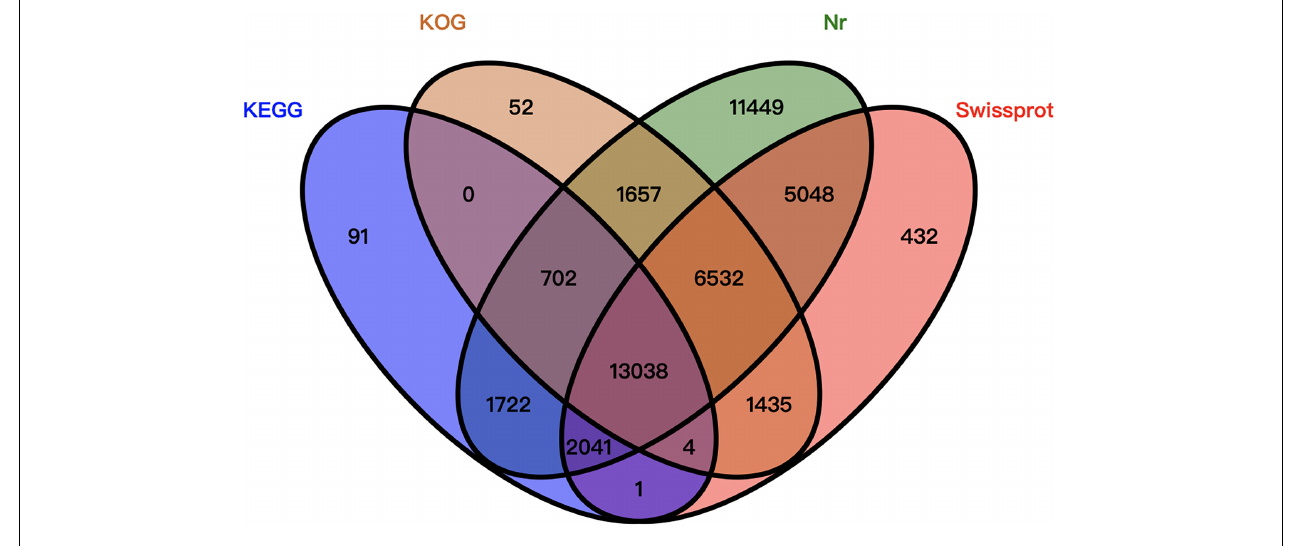
FIGURE 2 | Venn diagram summarizing the unigene annotations based on four databases.